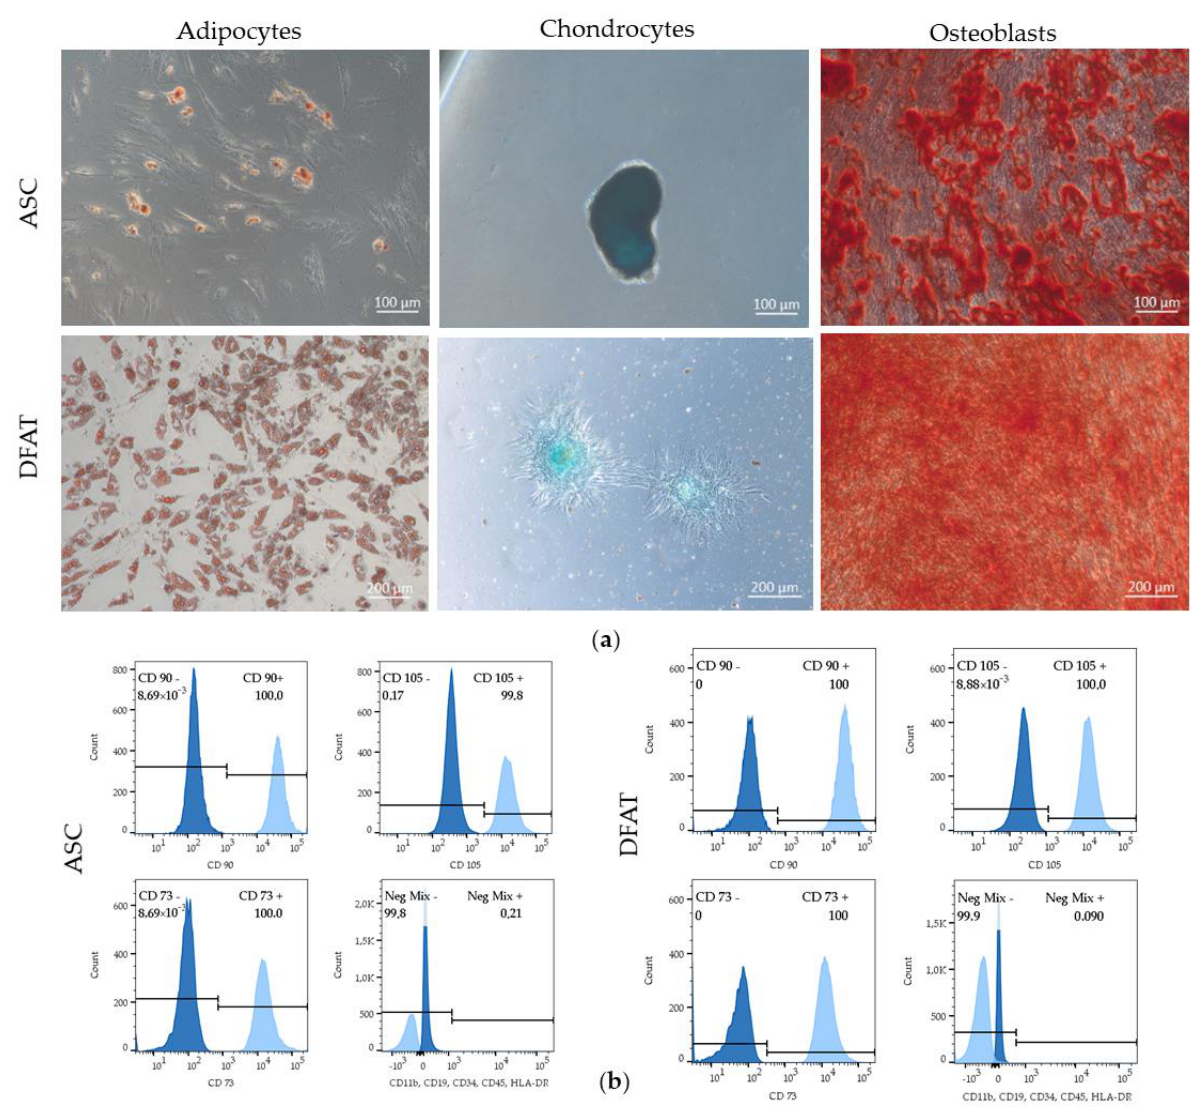
Figure 2. Properties of mesenchymal stem cells. ( a ) ASCs and DFATs differentiation into adipocytes, chondrocytes and osteoblasts. ( b ) Flow cytometry analysis of ASCs and DFATs; the presence of mesenchymal markers: CD73, CD90, CD105 and the absence of: CD34, CD11b, CD19, CD45 and HLA-DR at 2nd passage of culture.